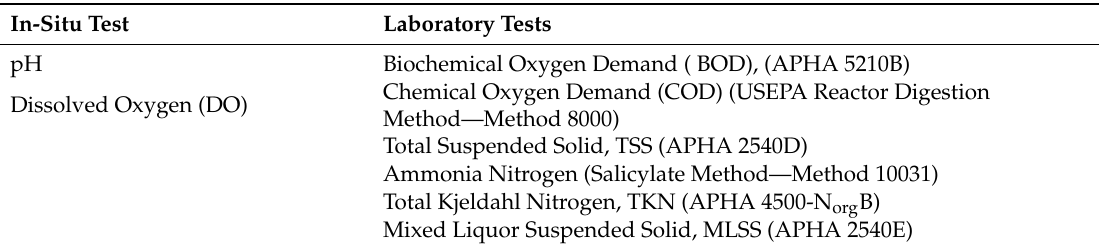
Table 2. Summary of experimental procedures.